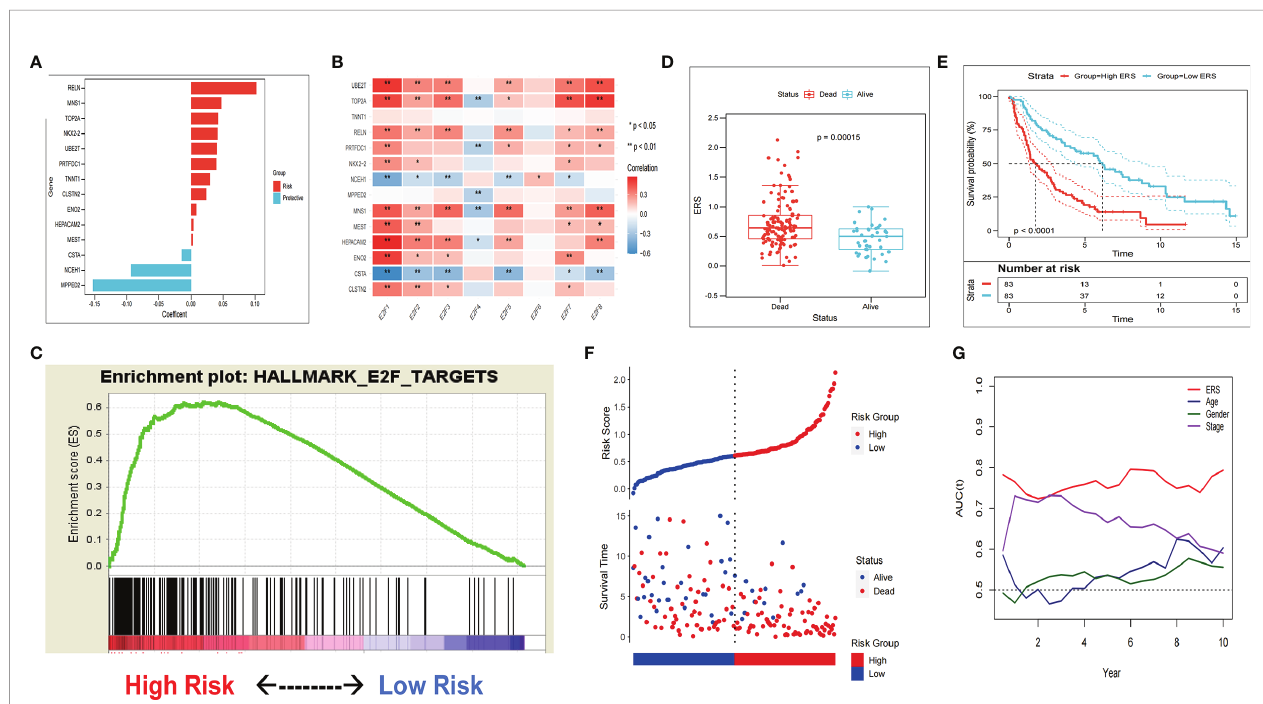
FIGURE 3 | The gene signature predicts worse survival of patients in the training set. (A) Distribution of LASSO coef fi cients of the E2F-related gene signature. (B) Association between gene signature and the E2F transcription factor family. (C) GSEA validated E2F pathway enrichment in the high-ERS group. (D) ERS was signi fi cantly increased in patients who died during follow-up. (E) The patients in the high-ERS group had worse survival. (F) Kaplan-Meier analysis showed a worse OS of patients with higher ERS. (G) tROC analysis showed ERS to be an accurate variable for survival